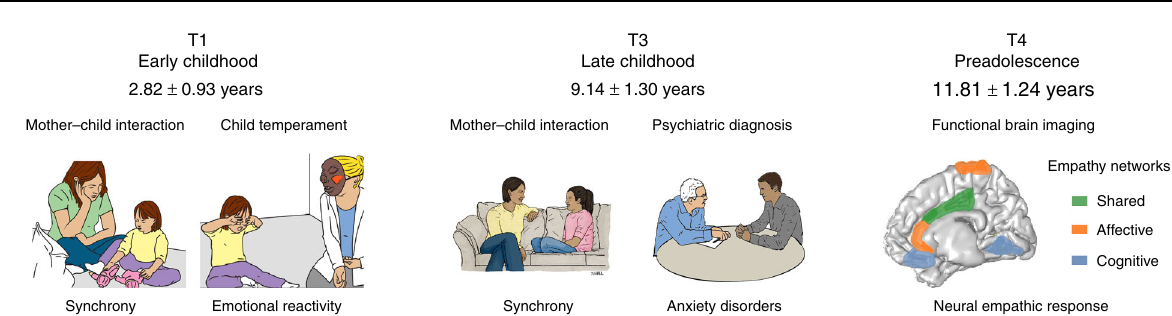
Fig. 1 Longitudinal study timeline. In T1, at early childhood, child and mother interacted with each other; mother – child synchrony was calculated. In T3*, Psychiatric diagnosis was conducted and child and mother interacted again and the synchrony construct was again computed; hence Maternal Synchrony scores leaned on the T1 and T3 interactions. In T4, neural empathic response to vicarious distress was evaluated using MEG neuroimaging. Illustration of empathy networks is inspired by the comprehensive review of de Waal and Preston 2 . *The Synchrony illustration is adapted and reproduced by permission of Oxford University Press. © The Author 2017. All rights reserved. For permissions, please email journals.permissions@oup.com. This fi gure is not included under the open access license of this publication. The original fi gure is Fig. 1a — Jonathan Levy, Abraham Goldstein, Ruth Feldman, Perception of social synchrony induces mother – child gamma coupling in the social brain. Soc. Cogn. Affect. Neurosci. 2017; 12 (7): 1036